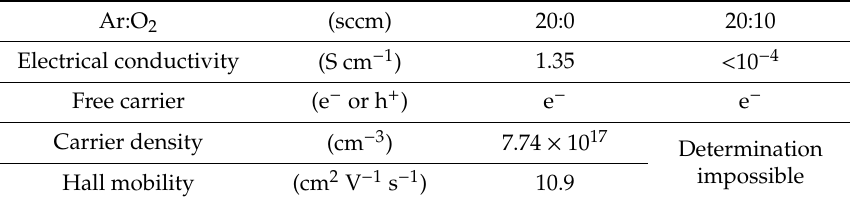
Table 1. Electrical characteristics of the α -GTO thin films.